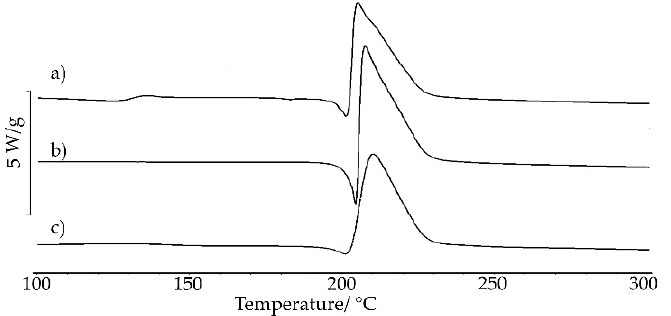
Figure 9. DSC curves for saccharin salts of chlordiazepoxide prepared using the following methods: ( a ) liquid-assisted grinding, ( b ) crystallization from ACN, and ( c ) crystallization from MeOH/ClMe. Measurements were taken at a heating rate of 10 °C/min in nitrogen.